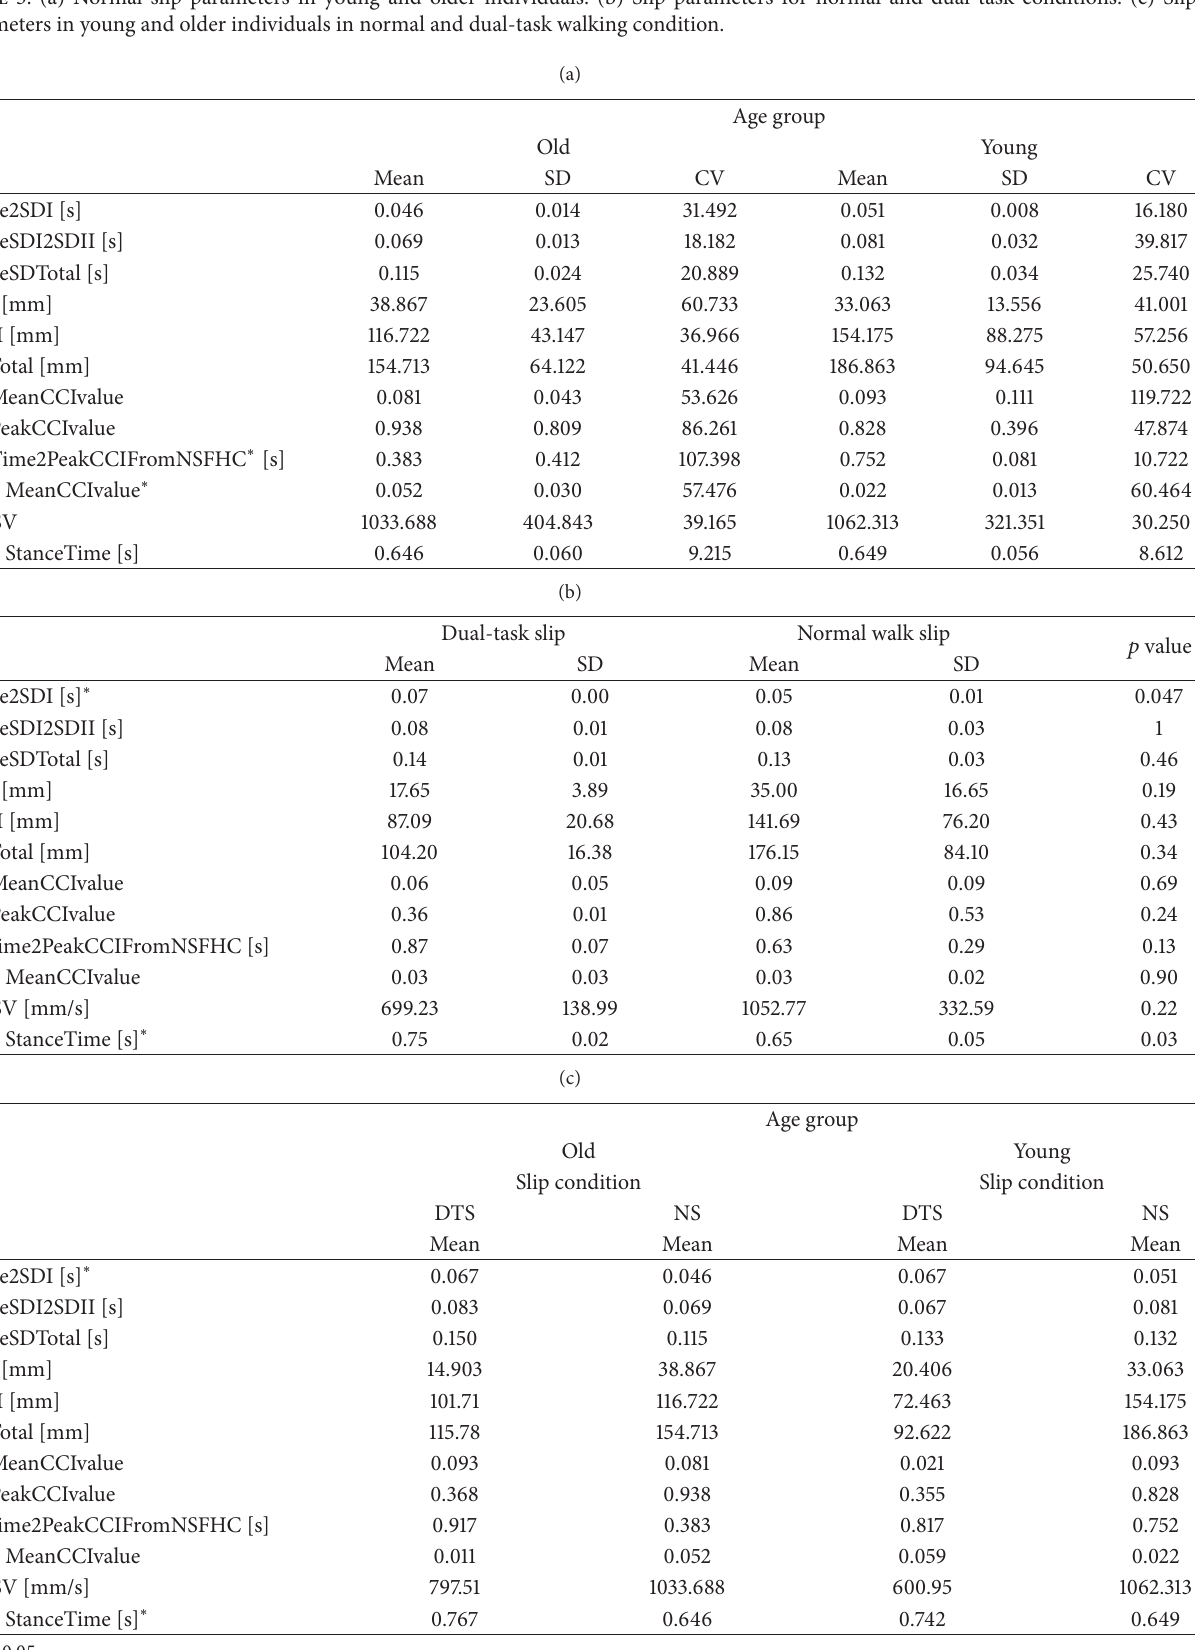
Table 3: (a) Normal slip parameters in young and older individuals. (b) Slip parameters for normal and dual-task conditions. (c) Slip parameters in young and older individuals in normal and dual-task walking